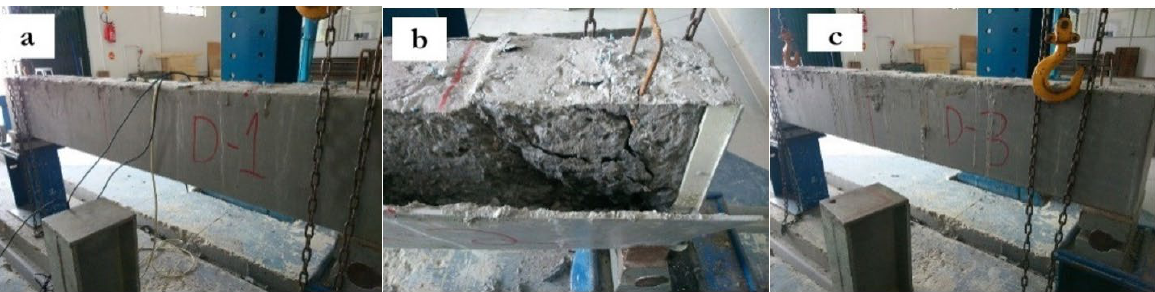
Figure 11. Beams of the group D after four-point bending tests. a) D-1. b) D-2. c)